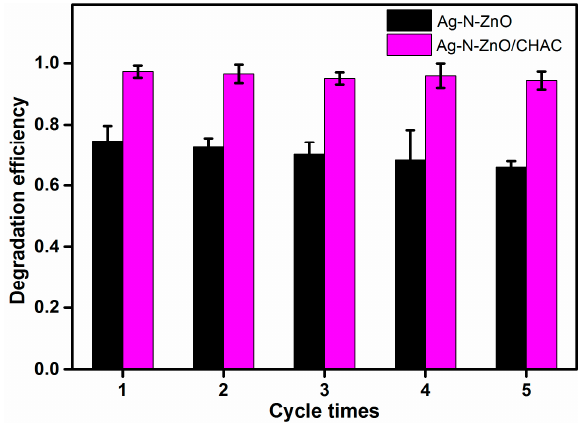
Figure 11. Recycled photoactivity testing of Ag-N-ZnO and Ag-N-ZnO/CHAC photocatalysts under visible light irradiation.